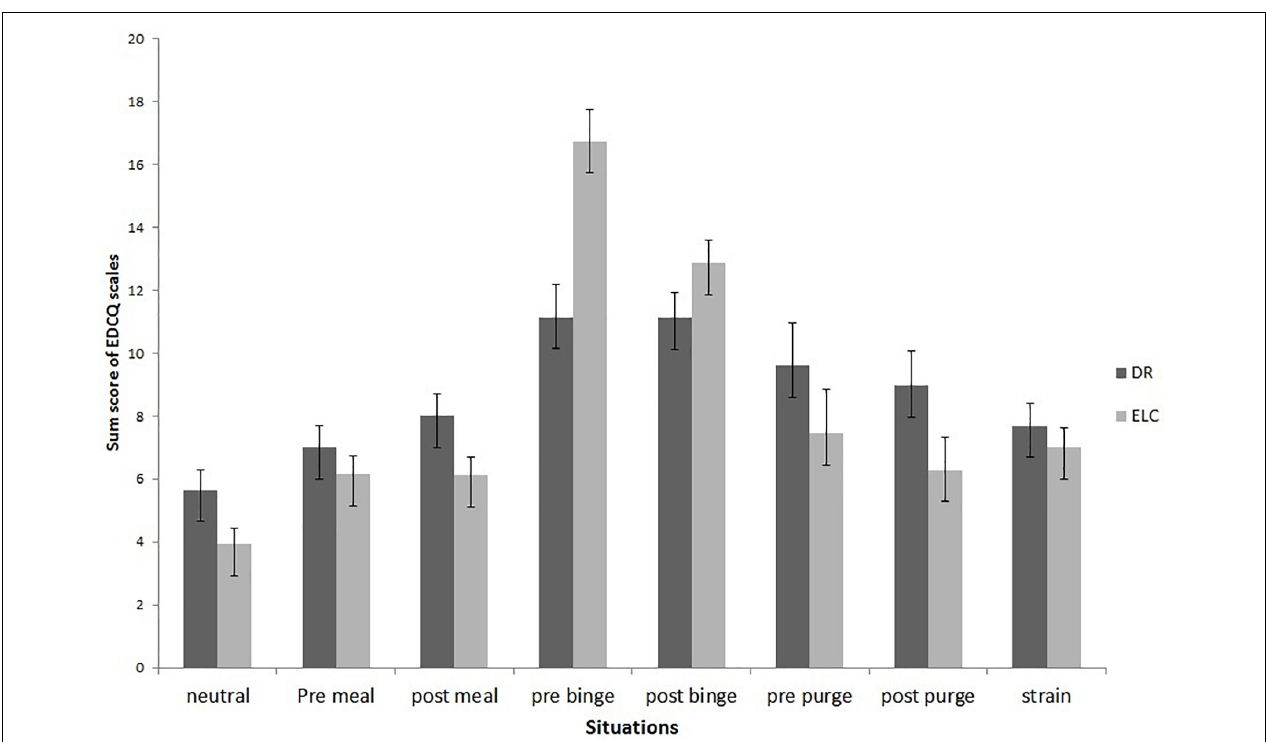
FIGURE 2 | Change of cognitive content depending on situational context. DR, thoughts about dietary restraint; ELC, thoughts about eating and loss of control; pre meal, pre meal situations; post meal, post meal situations; pre binge, pre binge situations; post binge, post binge situation; pre purge, situation before compensatory behavior took place; post purge, situation after compensatory behavior; strain, situation subjectively experienced as stressful. Eating Disorder Cognition Questionnaire